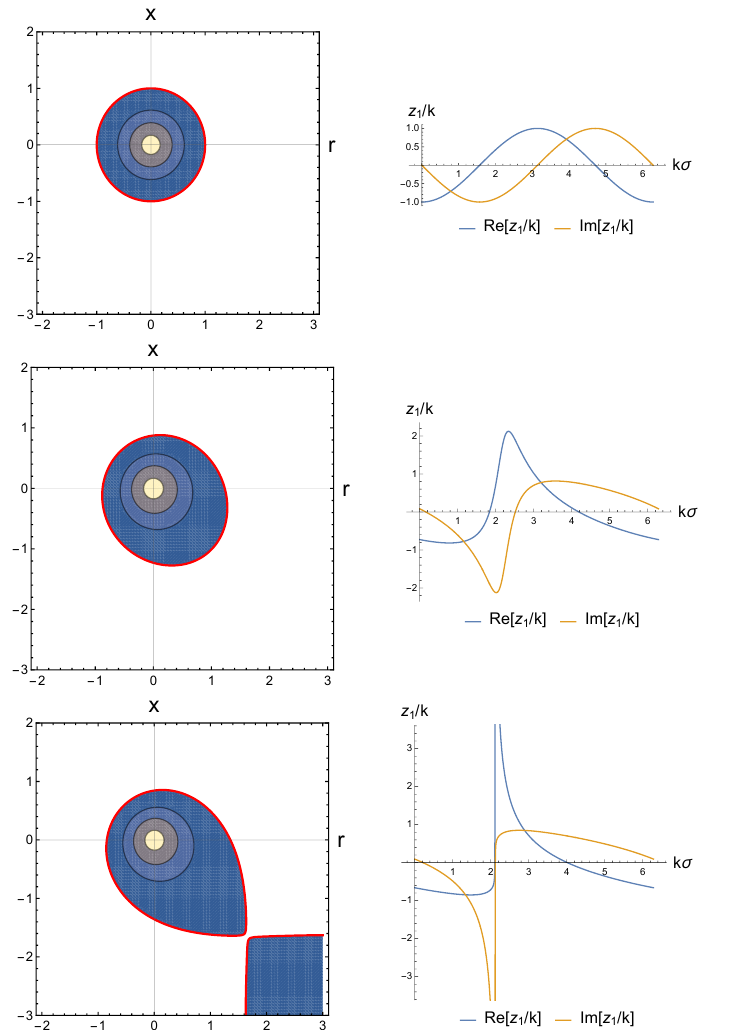
Figure 1 . Boomerang RG (cid:13)ow solutions for deformations of the Susy Q solution given in (5.14) with c = 1 and varying b 1 . On the left are contour plots of H in the complex w -plane, with the H = 0 locus marked with a red line. The right hand plots show the behaviour of z 1 ( (cid:27) ) = X 1 ( (cid:27) ) + iY 1 ( (cid:27) ), which (cid:12)xes the one point functions as discussed in section 4.2, and k (cid:17) 2 (cid:25)= (cid:1) (cid:27) . In particular, we have Y s = Y 1 and hO X i = X 1 . From top to bottom, the plots are for b 1 = 0 (i.e. Susy Q), b 1 = 0 : 4 and b 1 = 0 : 52. For larger values of b 1 the H = 0 locus is no longer a closed curve, the solution is no longer associated with a spatially periodic deformation and singularities